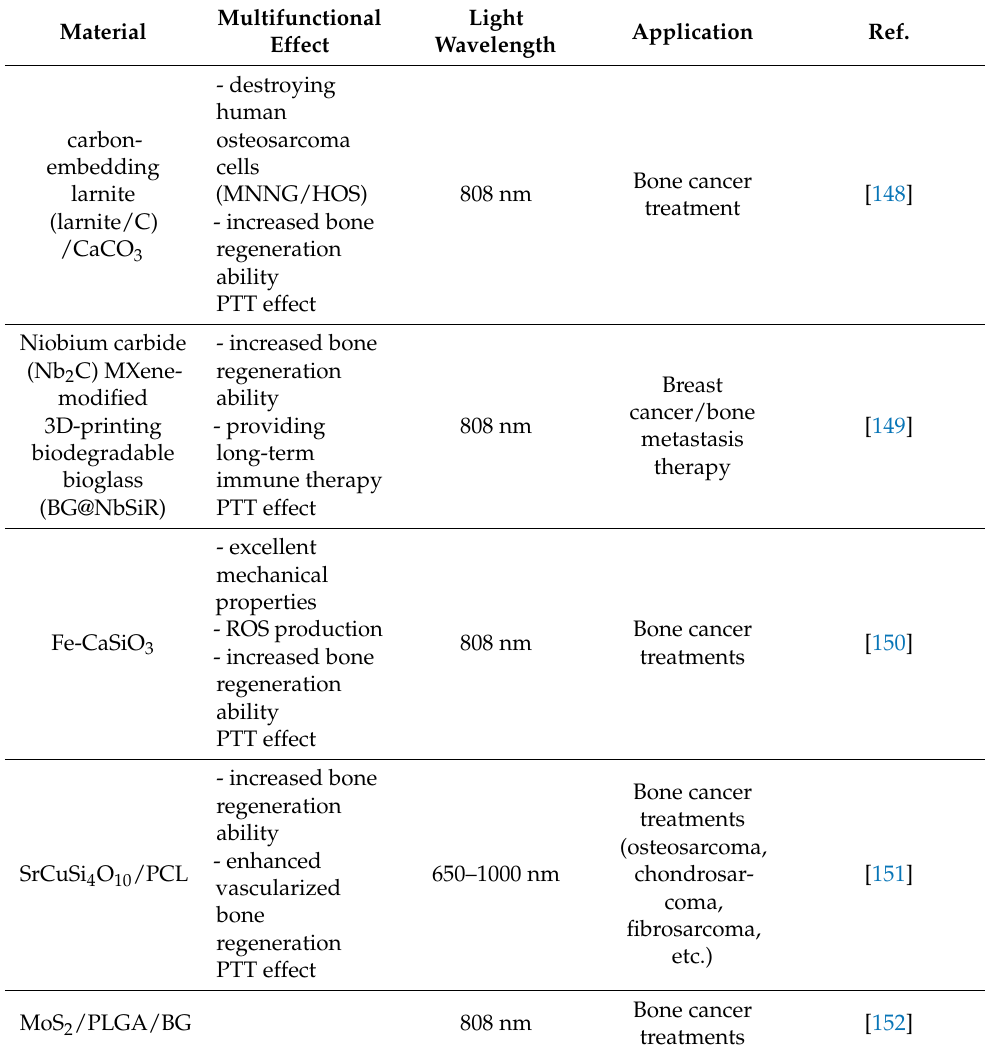
Table 4. Three-dimensional printed scaffolds combined with PTT